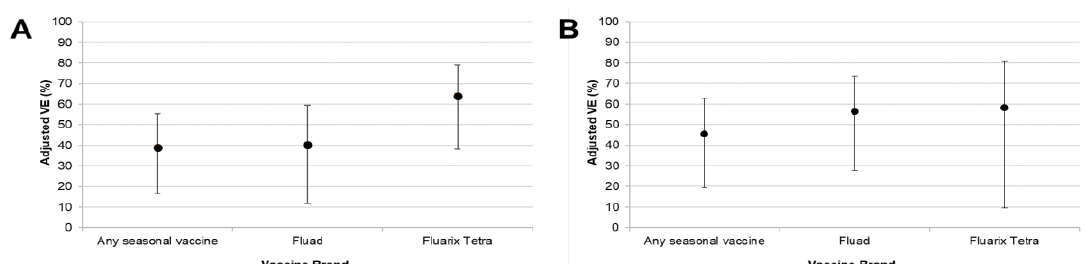
Figure 2. AdjustedestimatesofVE(95%CI)againstalltypeAinfluenza( A )andsubtypeA(H1N1)pdm09( B )stratifiedbyvaccinebrand. Abbreviations: Figure 2. Adjusted estimates of VE (95% CI) against all type A influenza ( A ) and subtype